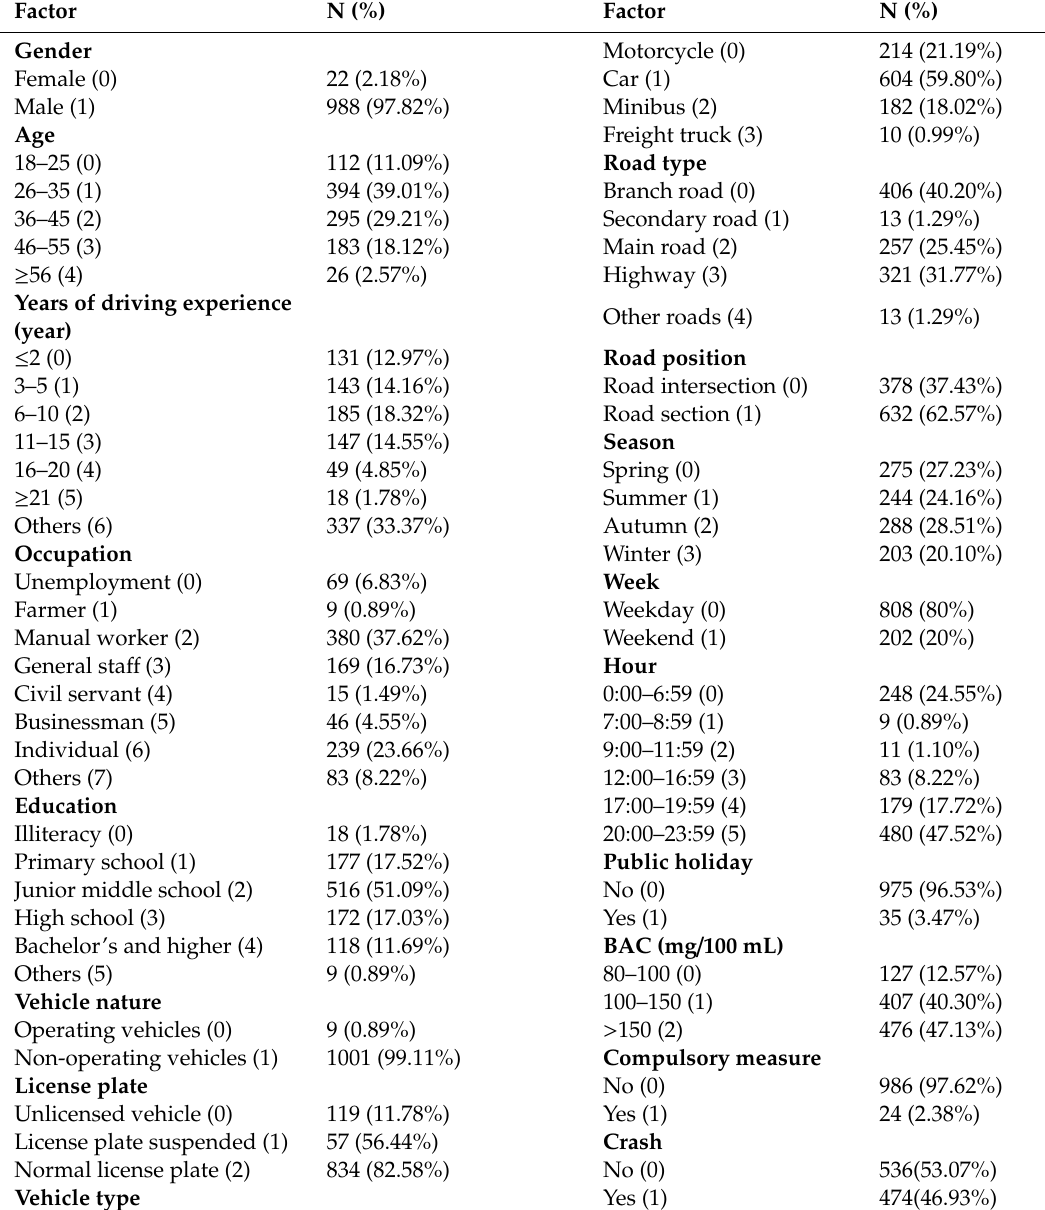
Table 1. Descriptive statistics of the variables (N =